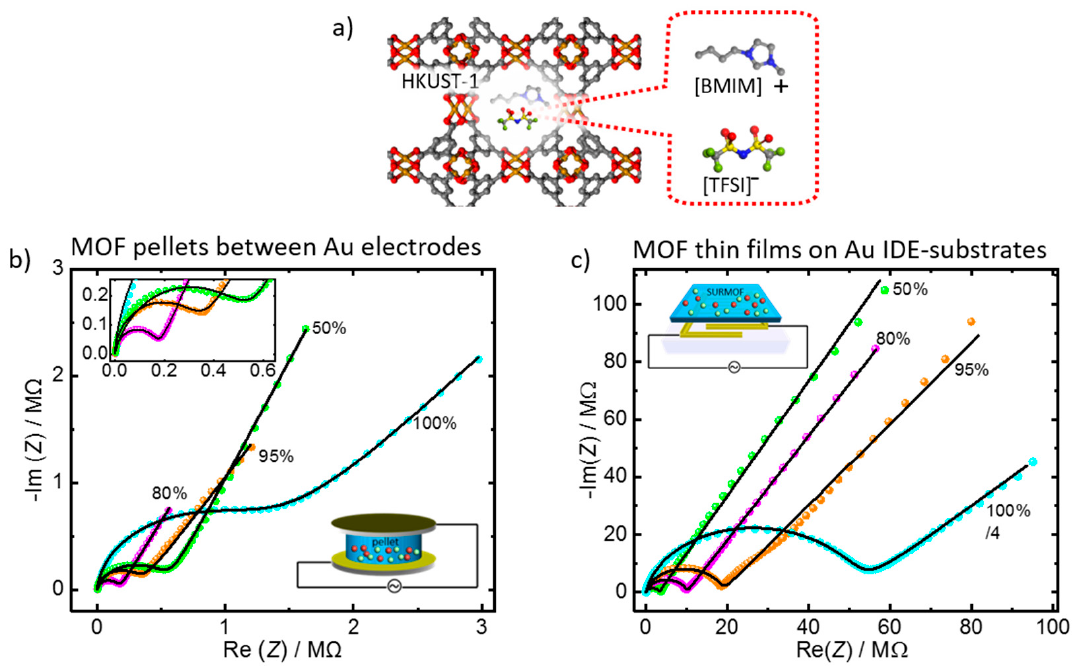
Figure 3. IL@HKUST-1. ( a ) Structure of IL of type [BMIM][TFSI] in HKUST-1 ( b ) and ( c ) Nyquist plots for the sample in the form of a MOF-pellet sandwiched between 2 gold electrodes ( b ), and in the form of a thin film on a glass substrate with interdigitated gold electrodes ( c ). The IL pore fillings are 50%, 80%, 95%, and 100%, as indicated. The black lines are the fits with the ( R-CPE dl ) (cid:107) CPE geo circuit. The frequency range is 100 Hz to 5 MHz ( b ), and 0.5 Hz to 5 MHz ( c ). Please note, for better visibility, the impedance values for 100%-loading in panel ( c ) are divided by 4, to allow the presentation in the same plot. The SURMOF sample was 0.25 µ m thick, deposited on a substrate with IDEs of 10 µ m gap distance and a total gap length of 1.69 m. The data of panel ( c ) are taken from [27] with copyright permission from 2019 American Chemical